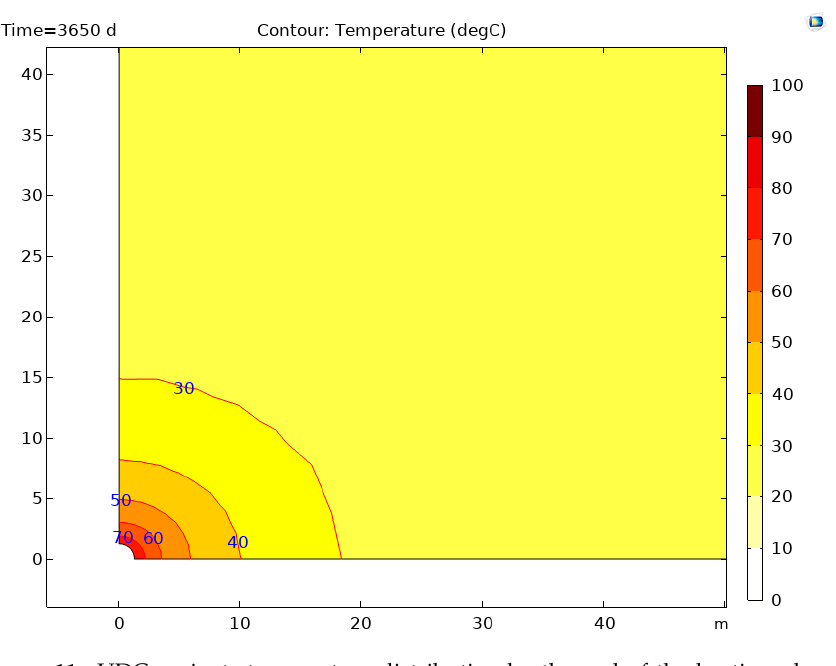
Figure 11. UDC variant: temperature distribution by the end of the heating phase (3650 days) (anisotropic stress conditions and anisotropic properties).